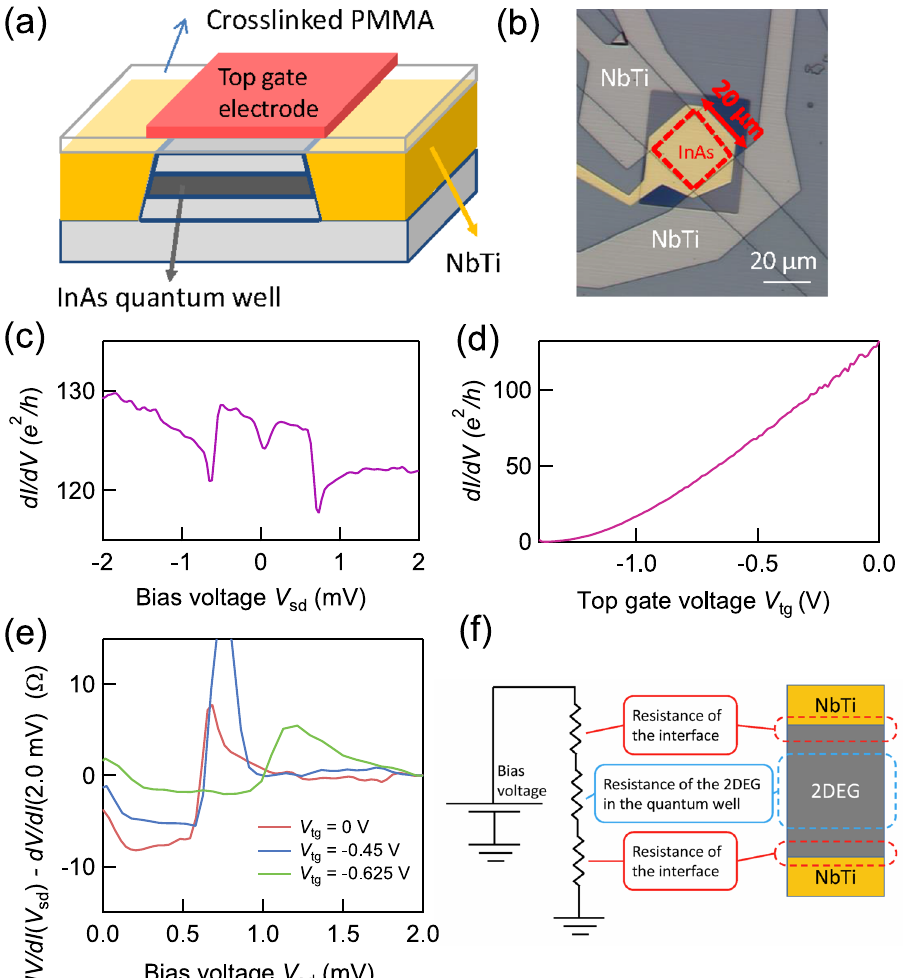
Figure 1. Device structure and the electron transport at B = 0 T. ( a ) Cross section of the fabricated device. The edges of the InAs QW are contacted with sputtered NbTi. ( b ) Optical image of the device. The region surrounded by the red dash line represents the mesa. ( c ) dI / dV vs. V sd at V tg = 0 V and B = 0 T. dI / dV measured in the range − 0.71 m V < V sd < 0.71 mV is enhanced due to AR. ( d ) dI / dV vs. V tg at V sd = 0 V is shown. The InAs QW is completely depleted by V tg . ( e ) dV / dI with dV / dI measured at V sd = 2.0 mV subtracted as a function of V sd is shown. The red, blue, and green lines are measured at V tg = 0, − 0.45, and − 0.625 V, respectively. The resistance reduction due to AR decreases as V tg decreases, indicating that V tg tunes the carrier density of not only the center region of the 2DEG but also region near the junctions. ( f ) Schematic image of an equivalent circuit to our junction devices. The applied V sd is divided between the two junctions and the